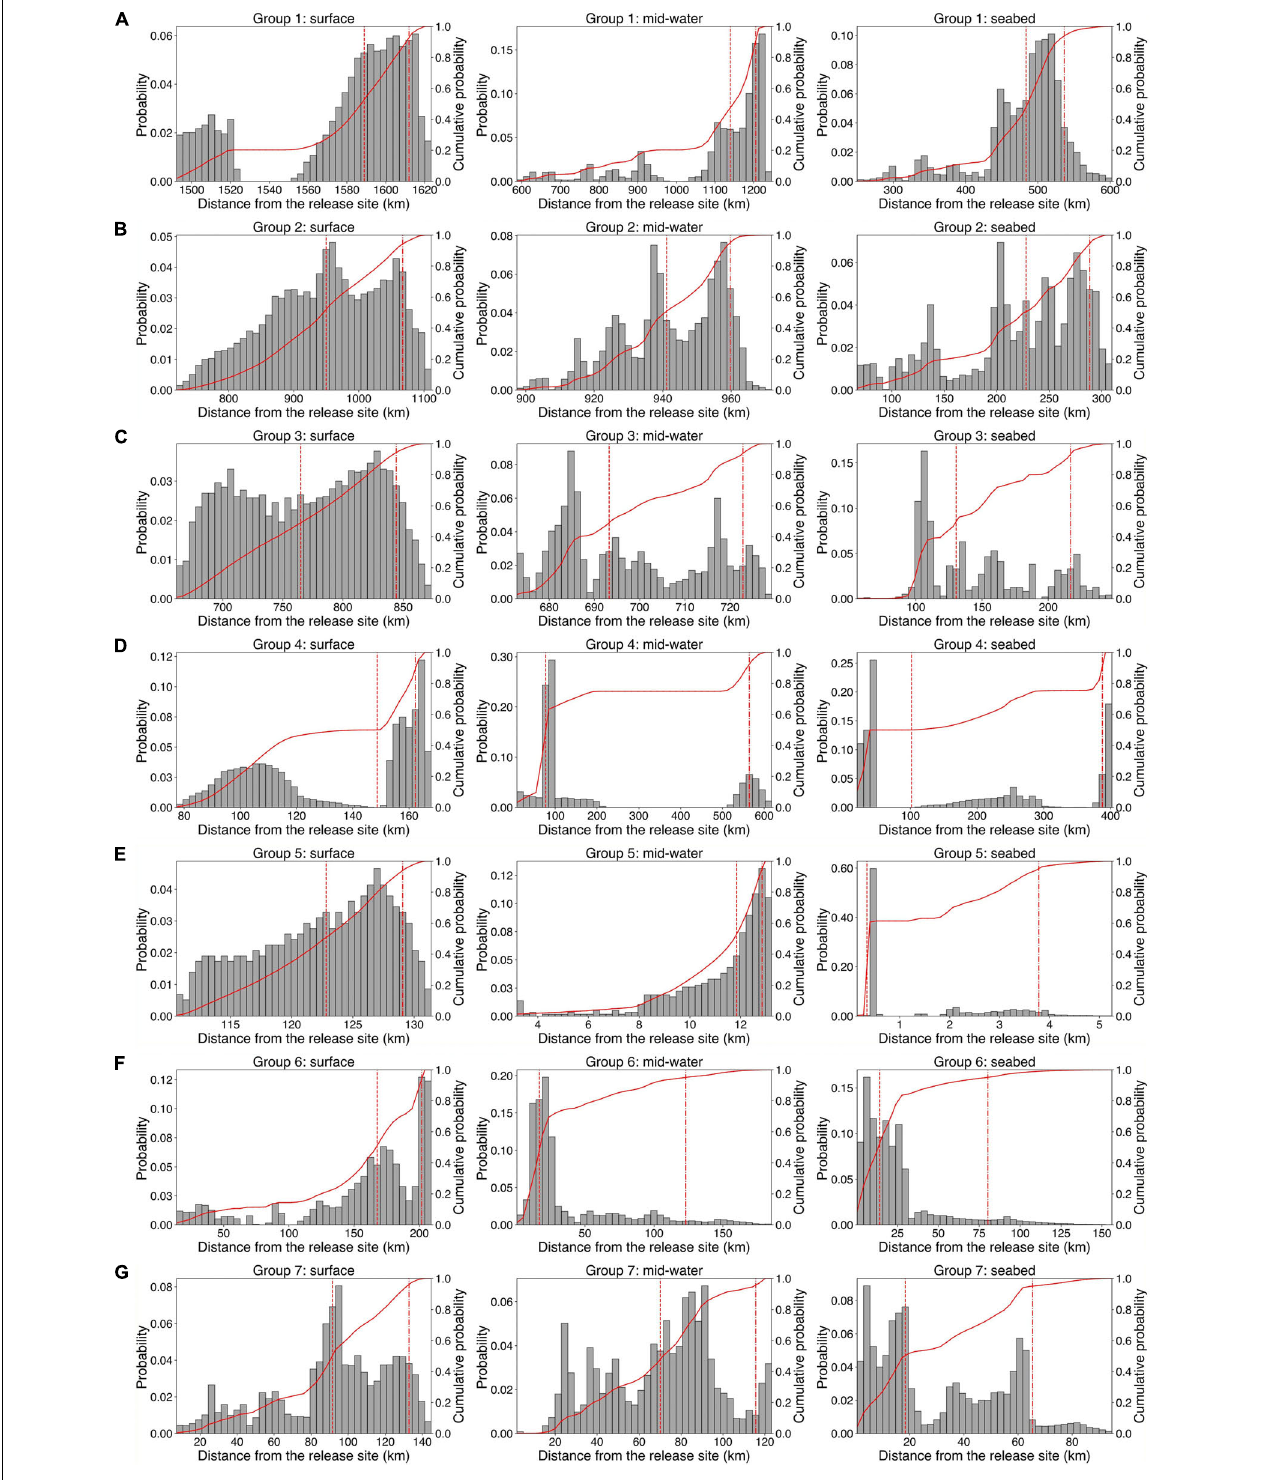
FIGURE 9 | Frequency distributions of maximum flow distances of particles released in July using long-term averaged currents from occupied grid cells in each Group at each release depth, modeled with k h = 0. (A) Group 1, (B) Group 2, (C) Group 3, (D) Group 4, (E) Group 5, (F) Group 6, and (G) Group 7. Bars show the dispersal probability values over the specified distance interval from the release sites, and red solid lines show the cumulative probability. The red dashed and dotted lines indicate the median and 95th percentile of the distances.